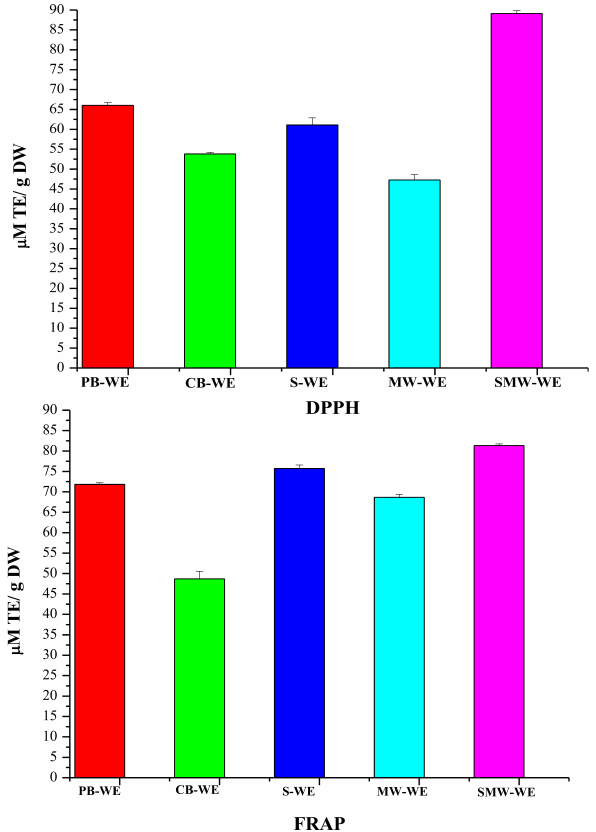
Figure 2. Comparative antioxidant properties of the Graviola leaf extracts using ( A ) DPPH assay and ( B ) FRAP